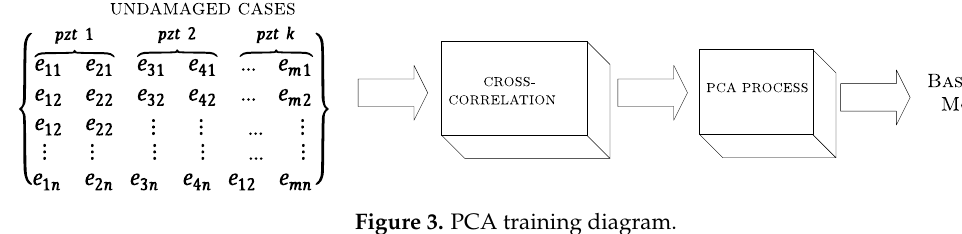
Figure 3. PCA training